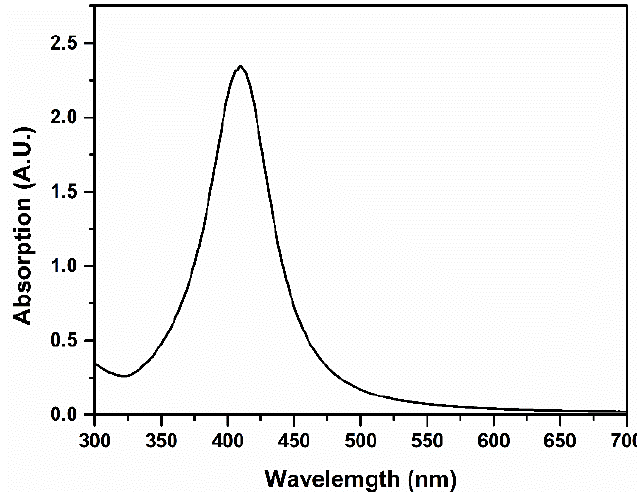
Figure 2. The linear absorption spectrum of AgNPs.